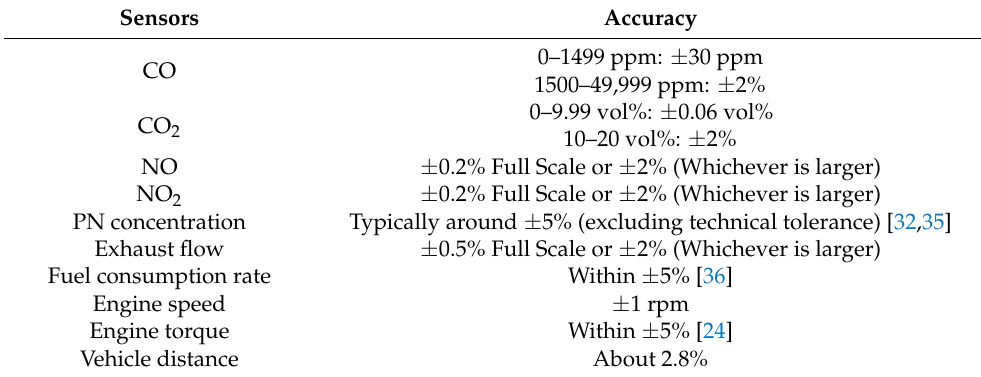
Table 6. Accuracy of the